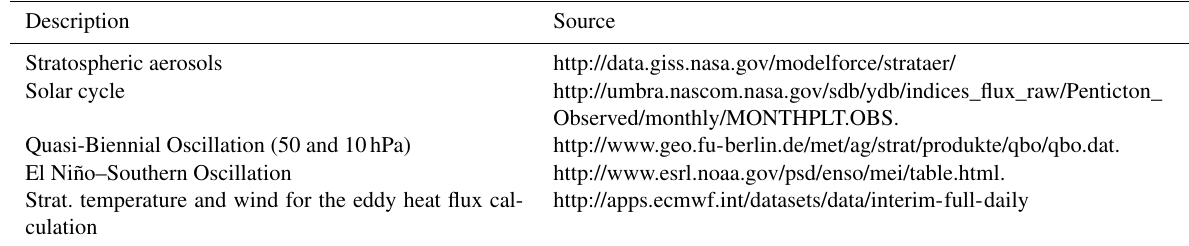
Table 2. Sources of the explanatory variables of the multiple regression.